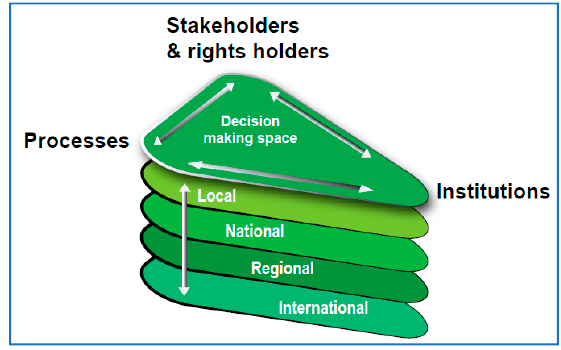
Figure 1. The structure of landscape governance, adapted from [17].